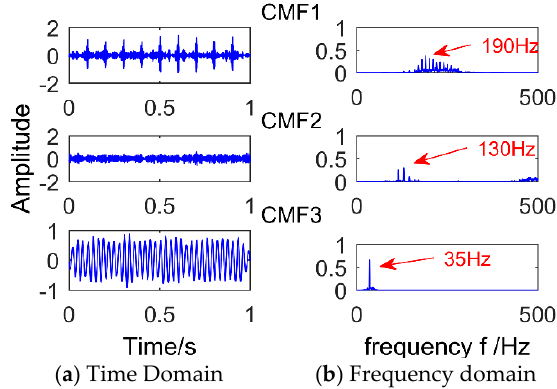
Figure 15. The results of component reconstruction.